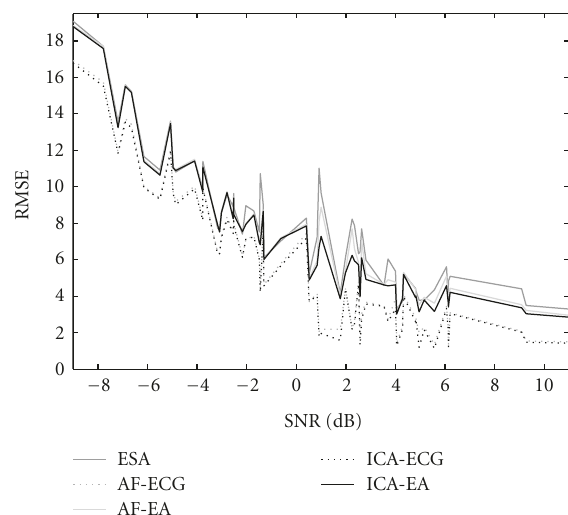
Figure 13: RSME according to SNR using simulated data with artificial ECG